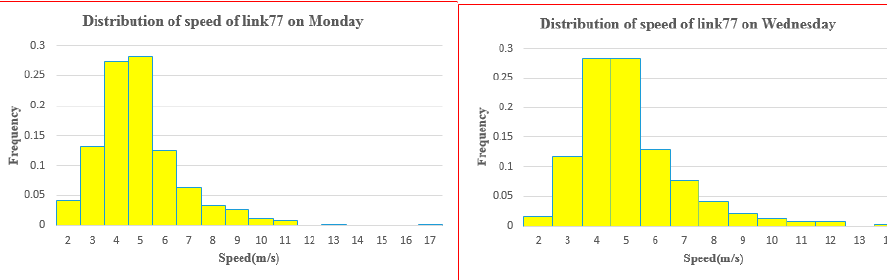
Figure 8. Distribution of speeds among the observations of link 77 on Monday and Wednesday.